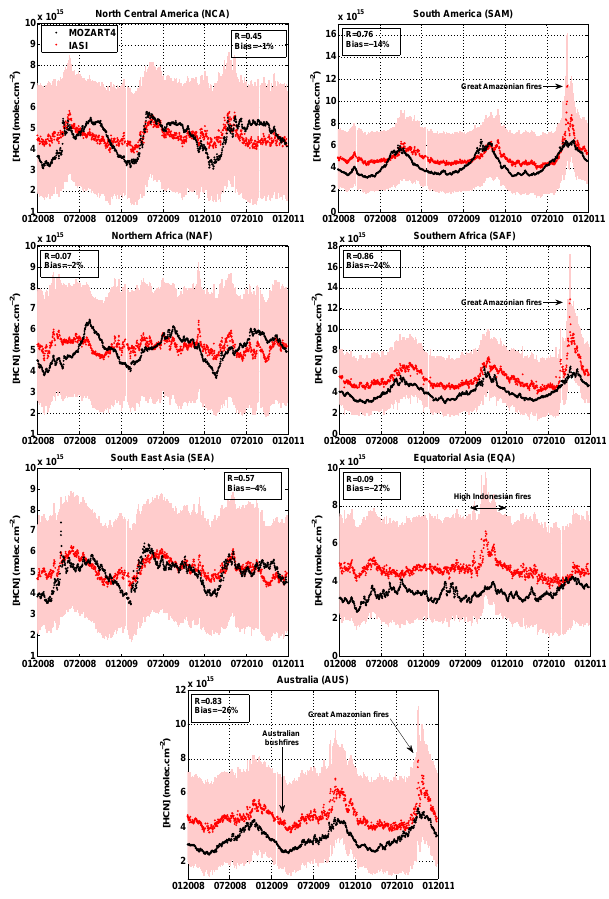
Figure10. SameasFigure11forHCN. Figure 12. Same as Fig. 11 for HCN.